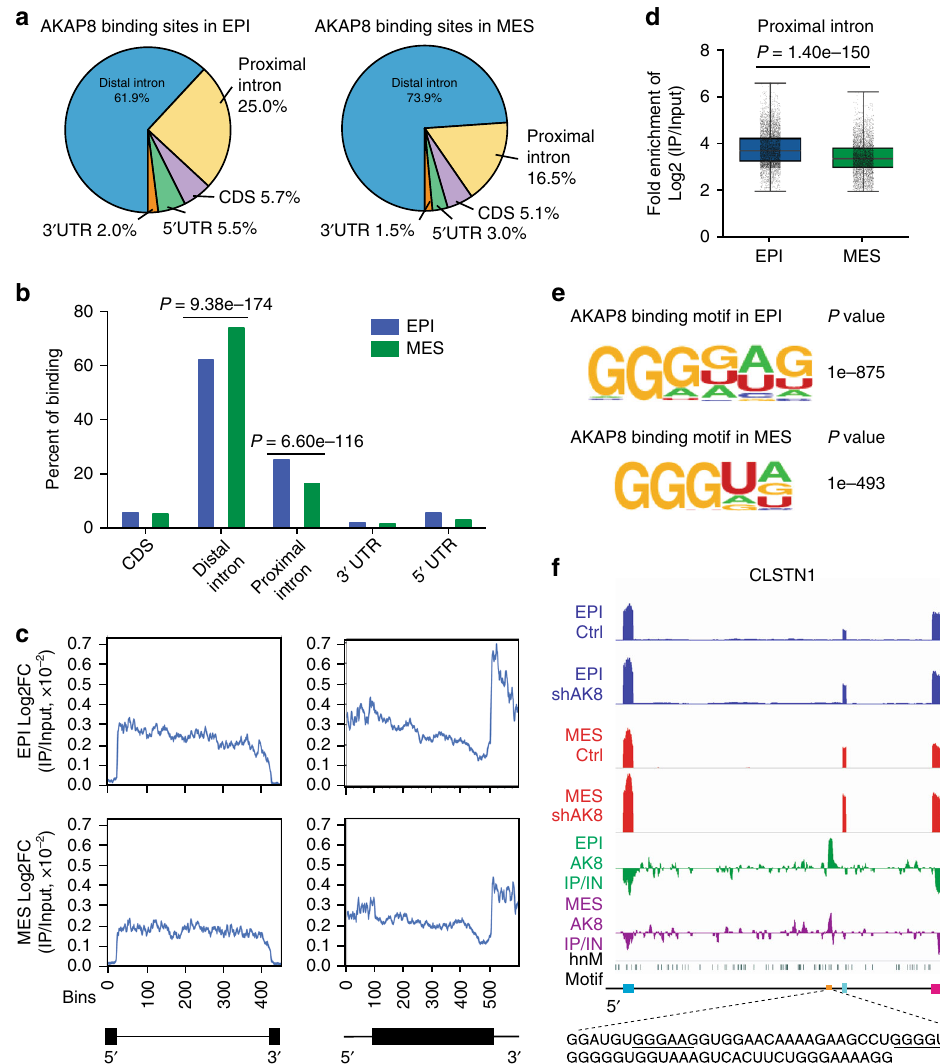
Fig. 6 AKAP8 eCLIP identi fi es its RNA-binding targets and cis-element motifs. a Distribution of AKAP8 eCLIP-binding sites across different regions of gene bodies. b Bar plot comparing the percentage of AKAP8-binding sites in each gene region between epithelial (EPI) and mesenchymal (MES) cell states. P values were computed by Fisher ’ s Exact test. c Metagenes plotting AKAP8-binding intensity (average log2FC IP/Input) in epithelial state (top panels) or mesenchymal state (bottom panels) across all introns (left panels) or exons (right panels). Introns (black line fl anked by two black rectangles) were scaled to 400 bins. The fl anking 50 nucleotides were split into 25 bins. Exons (black rectangle fl anked by two black lines) were scaled to 500 bins. The fl anking 1000 nucleotides were split into 100 bins. d Boxplots with jitters comparing the binding intensity (log2FC IP/Input) of all AKAP8-binding sites located in proximal introns showing that AKAP8 binds more strongly to proximal introns in the epithelial state compared with the mesenchymal state ( p computed by Student ’ s t test, two-tailed). The line within each box represents the median. Upper and lower edges of each box represent 75th and 25th percentile, respectively. The whiskers extend across the entire range of the data. e Weblogos depicting the most signi fi cant AKAP8 eCLIP-binding motif in epithelial and mesenchymal cells identi fi ed through de novo motif analysis. The two motifs are similar with guanine stretches of at least three nucleotides fl anked by uridine or adenine nucleotides. P values were determined by hypergeometric test. f Integrated genome viewer tracks centered on a cassette exon (exon 11) of CLSTN1, which undergoes exon inclusion upon AKAP8 (AK8) knockdown in the epithelial cells. Top four tracks represent autoscaled RPM-normalized RNA seq reads. Bottom two tracks represent IP/input normalized eCLIP signal. Black bricks indicate hnRNPM (hnM) binding motifs (GU-rich). Bottom cartoon shows CLSTN1 cassette exon in light blue fl anked by upstream (dark blue) and downstream (pink) constitutive exons. Yellow bar indicates AKAP8 eCLIP-binding site. Zoomed out sequence indicates nucleotide sequence covered by binding site with AKAP8 motifs underlined. Source data are provided as a Source Data fi expression of the non-targeted isoforms (Fig. 7b, bottom panel). stage were largely maintained in the epithelial state (Fig. 7c – e). TAM induction of EMT in the HMLE/Twist-ER control and These results reveal that silencing CLSTN1-S promotes EMT. CLSTN1-S shRNA-expressing cells showed that silencing Although silencing CLSTN1-L did not show an overt difference CLSTN1-S-accelerated EMT signi fi cantly within 8 days (Fig. 7c). compared with control cells, it caused signi fi cant cell death after These cells also switched expression from epithelial markers to the TAM induction for 4 days (Supplementary Fig. 7a), implying mesenchymal markers (Fig. 7d) and displayed loss of E-cadherin that CLSTN1-L is required for cell survival during EMT. As at the cell junctions (Fig. 7e). By contrast, control cells at this CLSTN1 transcripts levels remain relatively consistent in